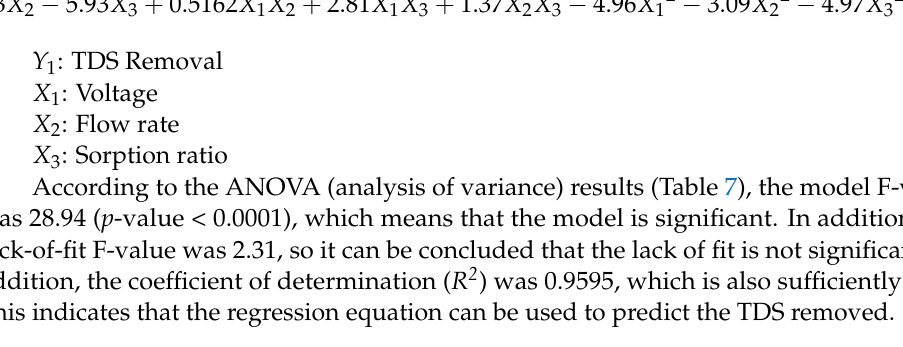
Table 7. ANOVA for the response surface quadratic model.